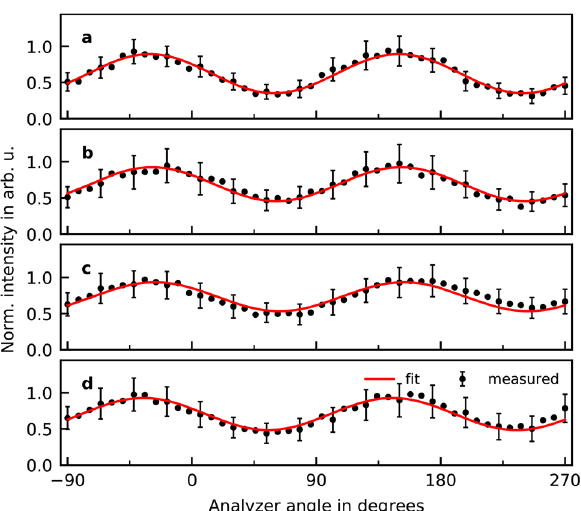
Figure 5. The recorded signal as a function of the analyzer azimuthal angle θ measuremed for XUV-radiation centered around harmonic with orders (a) H13, (b) H16, (c) H19 and (d) H22 from Fig. 2 for −1.8 fs delay.